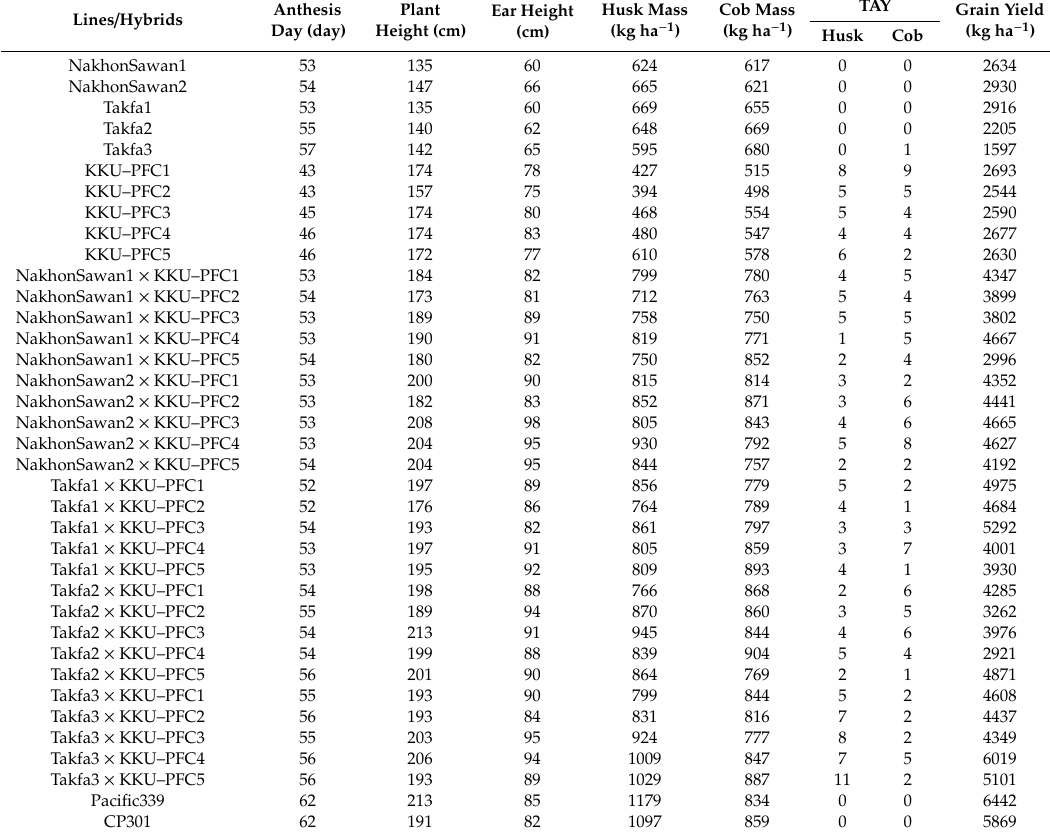
Table 6. Mean performance for agronomic traits, anthocyanin yield, and grain yield of parents, their hybrids, and control cultivars across two